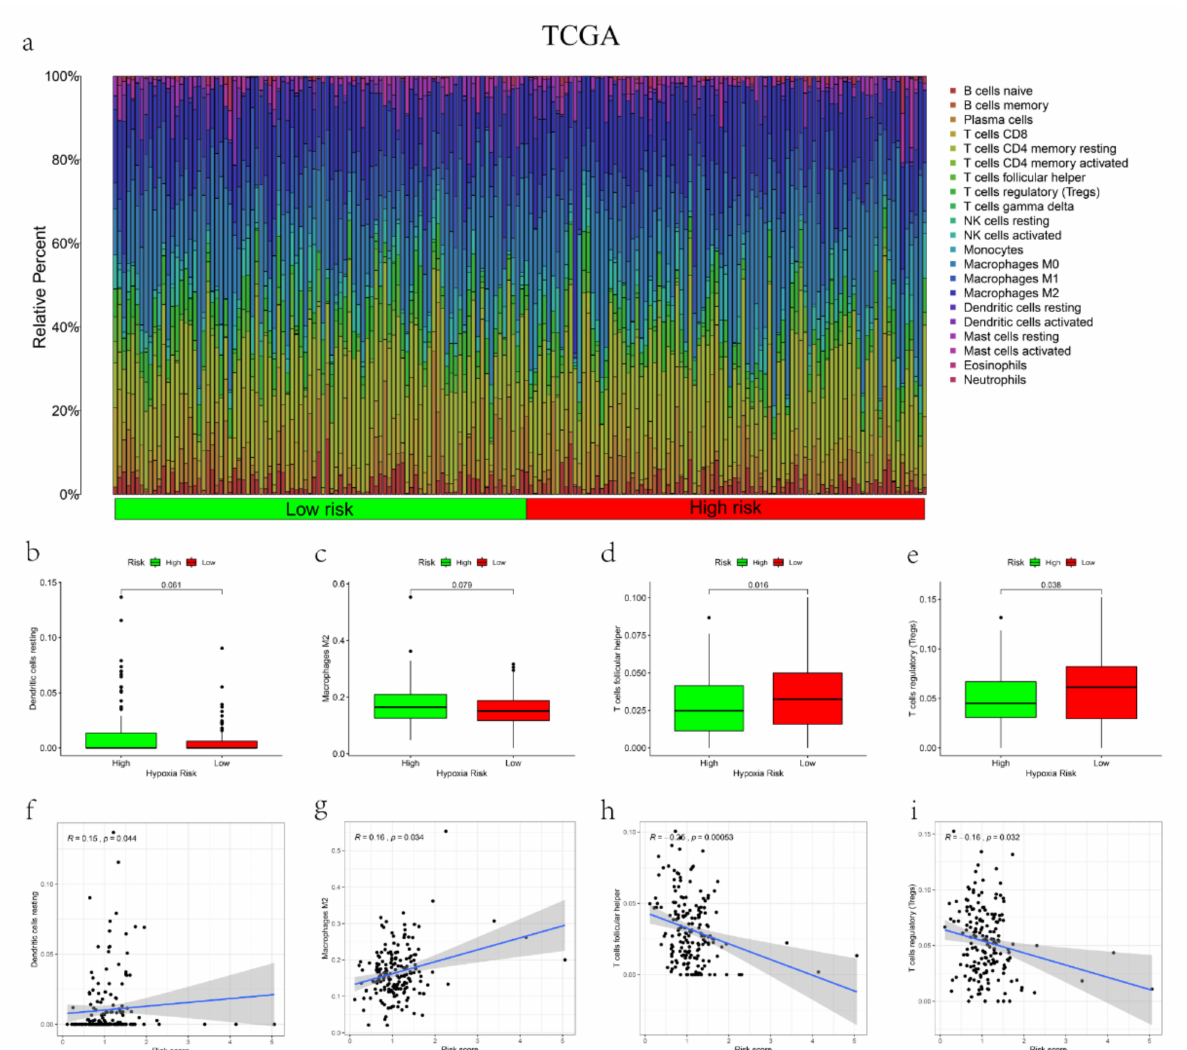
Figure 5. Relationships between the risk score and immune cell infiltration and the role of the mRLs in tumor microenvironment in TCGA dataset. ( a ) The proportion of 22 immune cells infiltration in high- and low-risk groups. ( b – i ) Correlation of expression of the mRLs and infiltration of specific immune cell type. In TCGA-entire set, N =